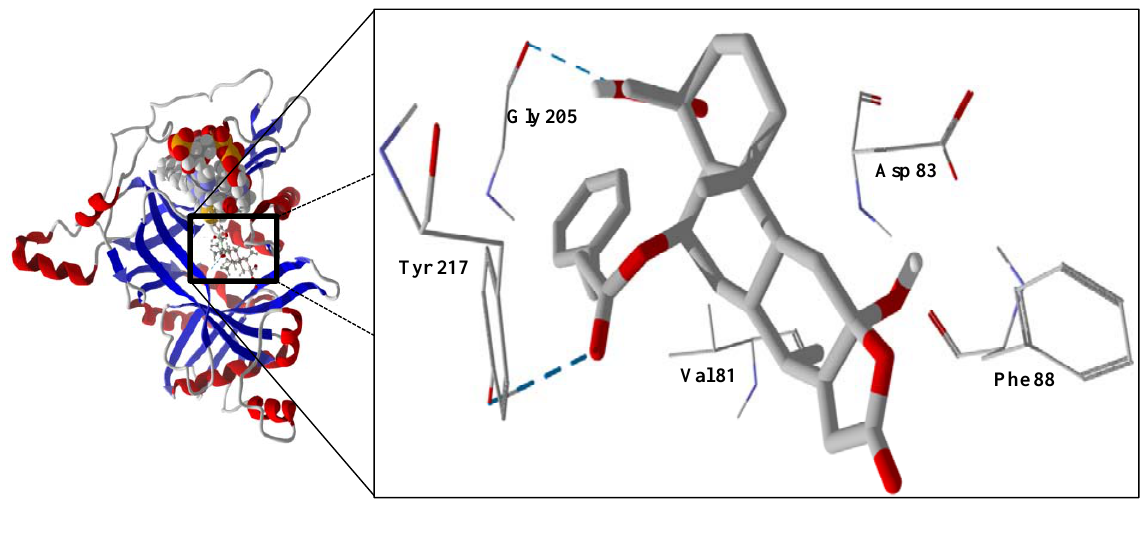
Figure 19. The lowest-energy pose of 6 β - O -2 ' 3 ' -dihydrocinnamoyl-12-hydroxy-(13)15-en- 16,12-olide-18-cassaneoic acid and LmajNMT. The hydrogen bonding interactions between the ligand and the protein (Gly 205 and Tyr 217) is shown as blue dash lines. Val 81, Asp 83 and Phe 88 were also predicted to have very strong steric interactions with the